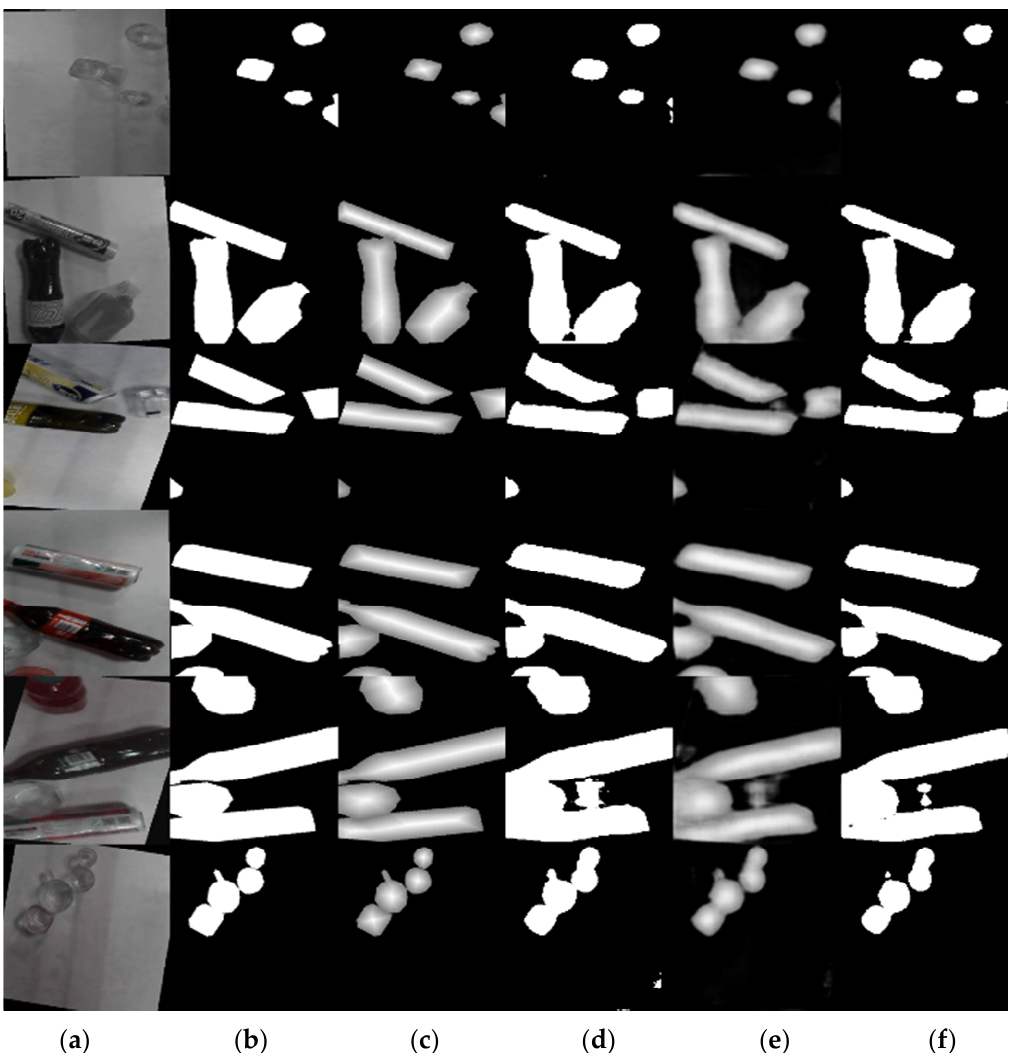
Figure 10. Results of LSMNet on the OSIC dataset. ( a – f ) Original image, mask ground truth, LSM ground truth, mask output, LSM output, and consistency output, respectively.